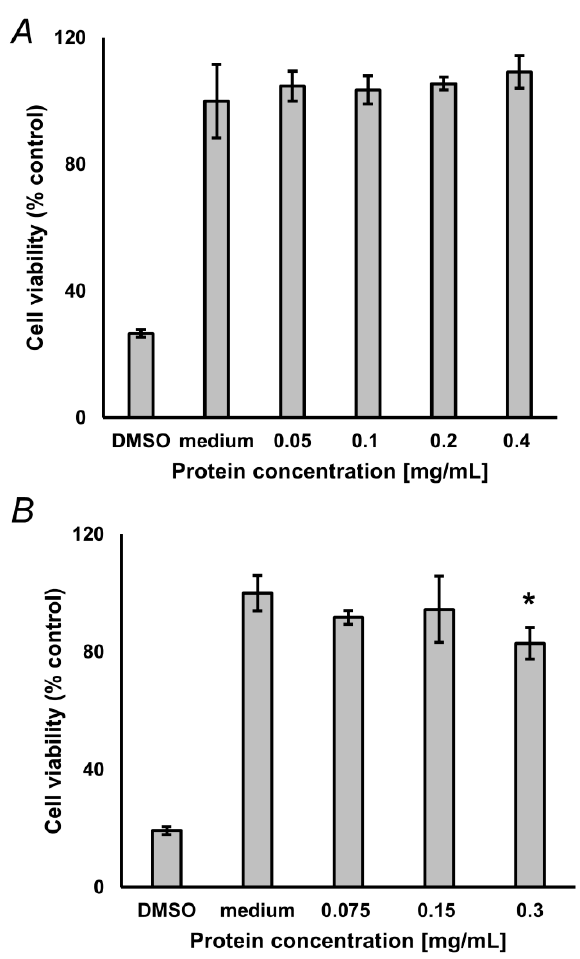
Figure 5. Results of the 3-(4,5-dimethylthiazol-2-yl)-2,5-diphenyltetra-zoliumbromid (MTT) assay, performed with 0.05–0.4 mg/mL glycated bovine serum albumin (BSA, n = 3, A ) and 0.075–0.3 mg/mL protein isolated from pea seeds ( n = 3, B ), not subjected to accelerated ageing. Analyses were performed in triplicates. Culture medium served as negative control. DMSO served as positive control. * Difference was significant ( t -test) at the confidence level of p < 0.05).